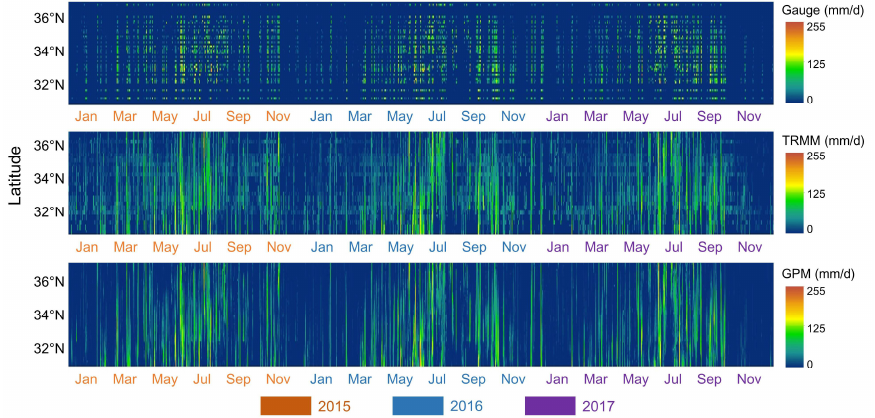
Figure 10. Comparison of satellite products (TRMM 3B42 v7 and GPM IMERG v5) and gauge observations with latitudes over the Huaihe River basin from 2015 to 2017.